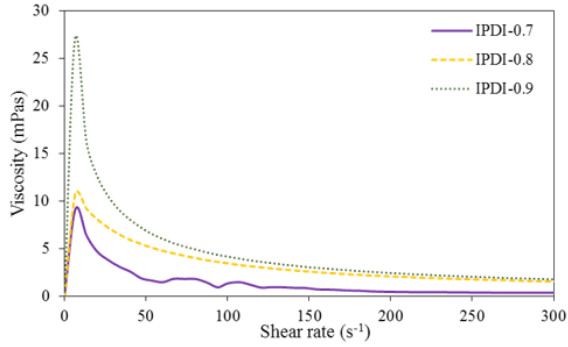
Figure 11. Rheological behaviors of WUOs synthesized using IPDI and different NCO/OH mole ratios.